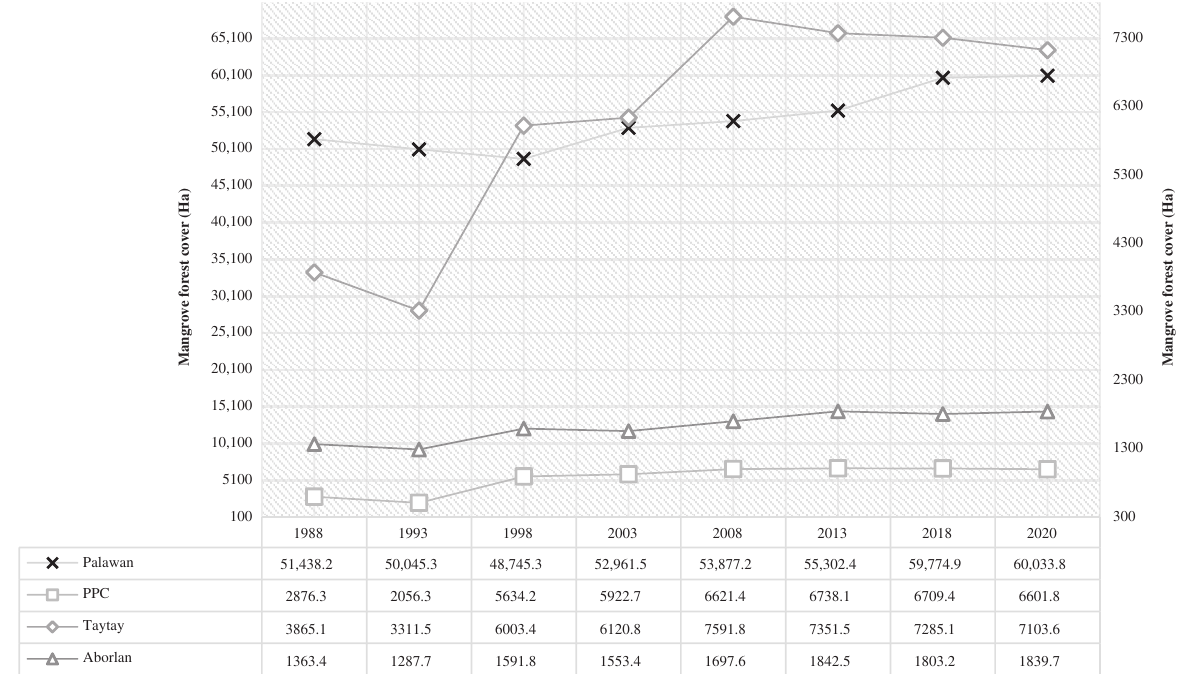
Figure 4 Composite representation of area statistics of mangroves in Palawan (left y -axis), PPC, Taytay and Aborlan (right y